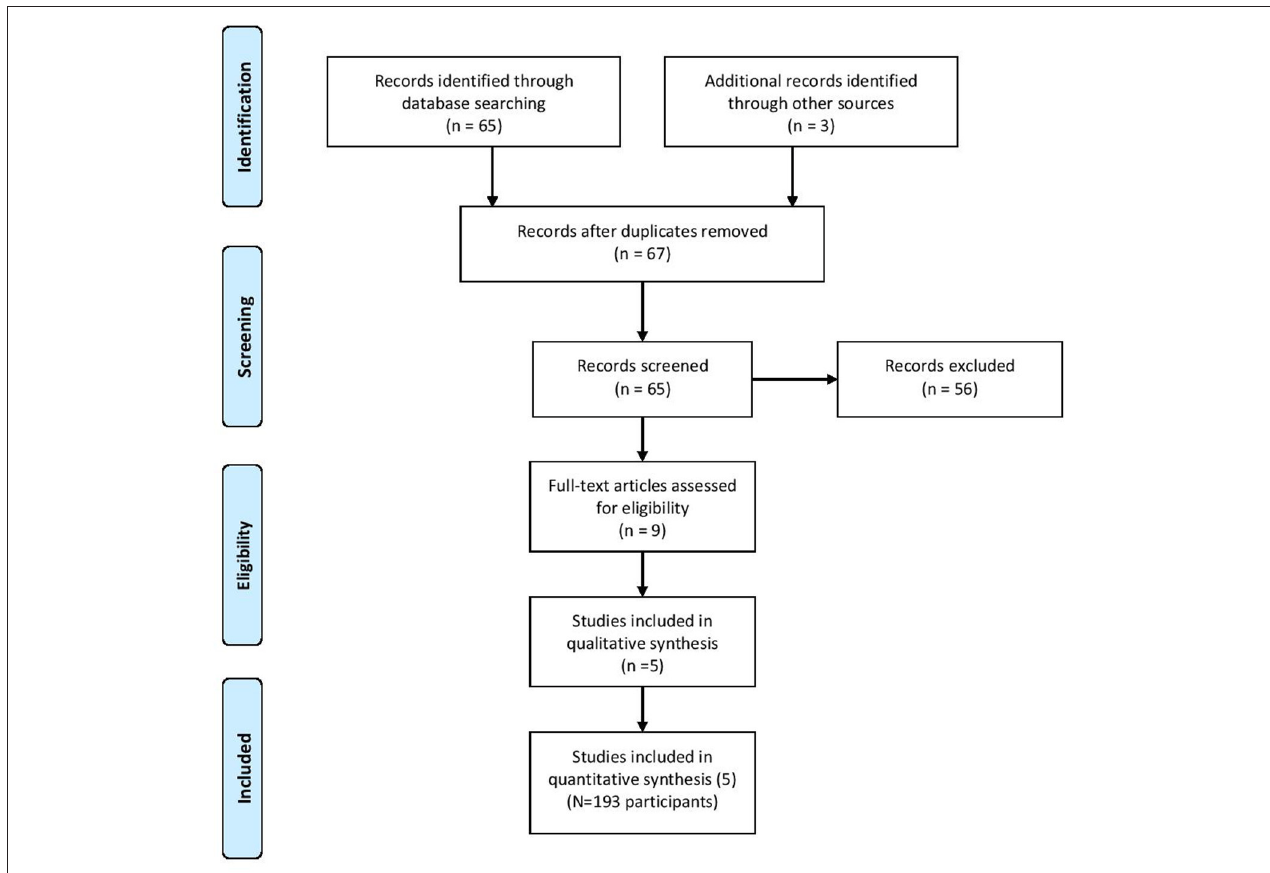
FIGURE 1 | PRISMA flow